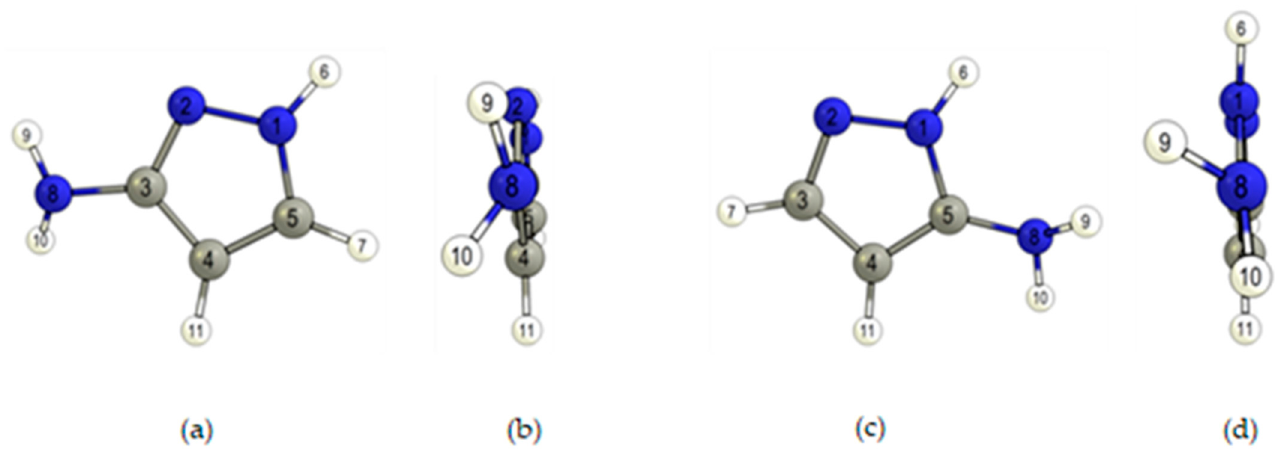
Figure 1. DFT(B3LYP)/6-311++G(d,p) optimized structures of 3AP (structures ( a , b )) and 5AP (structures ( c , d )) tautomers, with the atom numbering adopted in this work. Colors: C-grey, H-white and N-blue.